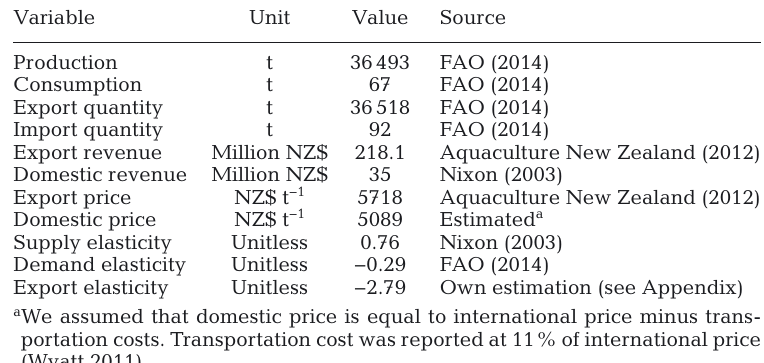
Table 3. Data inputs for the partial equilibrium model that was used to capture the societal effects, i.e. the changes in the producer and consumer surpluses that result from a price change of green-lipped mussels, which may be affected by the presence of Styela clava and Sabella